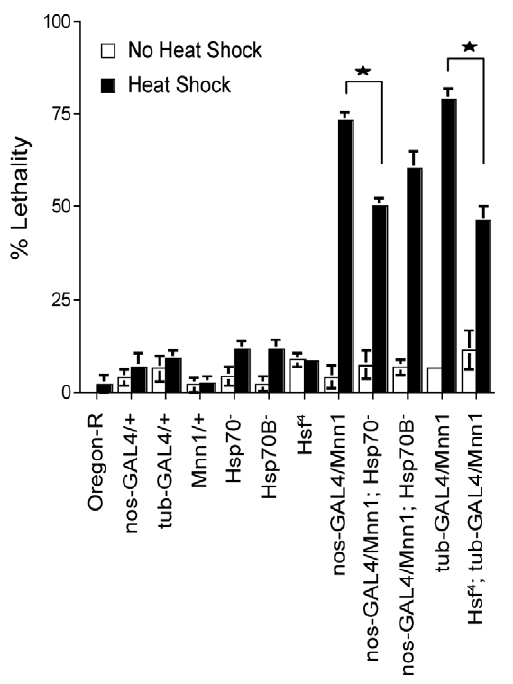
Figure 4. The lethality observed in transgenic strains over- expressing menin is partially due to aberrant Hsp70 expres- sion. Stage 6 to 10 embryos (3 to 5 hrs AEL) were subjected to a 1 hr heat shock treatment at 37 u C and then allowed to develop until adulthood. Mnn1 refers to strains harboring a UAS construct of this gene; expression is driven by either the nanos-GAL4 or tubulin-GAL4 drivers. Under heat shock conditions, organismal lethality of menin over-expressing lines ( nos - GAL4 / Mnn1 and tub - GAL4 / Mnn1 ) was atten- uated when these strains were placed in an Hsp70 - mutant background ( nos - GAL4 / Mnn1 ; Hsp70 - ) or with a temperature sensitive Hsf - allele ( Hsf 4 ; tub - GAL4 / Mnn1 ). Lethality of menin over-expressing lines was not attenuated by deletion mutants for a single Hsp70 locus ( nos - GAL4 / Mnn1 ; Hsp70B - ). Percent lethality of wild-type (Oregon-R), parental control lines ( nos - GAL4 / + , tub - GAL4 / + and Mnn1 / + ) as well as homozygous Hsf 4 and Hsp70 - mutants, and mutants homozygous for a single Hsp70 locus ( Hsp70B - ) are shown for comparison. Stars denote significant differences between the indicated strains, p , 0.05. Error bars represent SEM. Genes showing important fold-changes in induction include those encoding the major heat shock proteins. This group of genes is located in a single cluster shown in the lower part of Fig.6A and enlarged in Fig. 6B. A profound disruption in the in the absence of menin, either as a result of gene deletion ( Mnn1 e30 ) or expression of a dsRNA ( UAS-Mnn1 - RNAi ). In these conditions, none of these heat shock responsive genes were expressed after a 1 hr heat stress at 37 u C, indicating that menin acted as a global regulator of heat shock protein genes (Fig. 6B, lanes 6–8). However, the induction of Hsp genes was normal after a 10 min heat shock treatment (Fig. 6B, lanes 1–4), suggesting